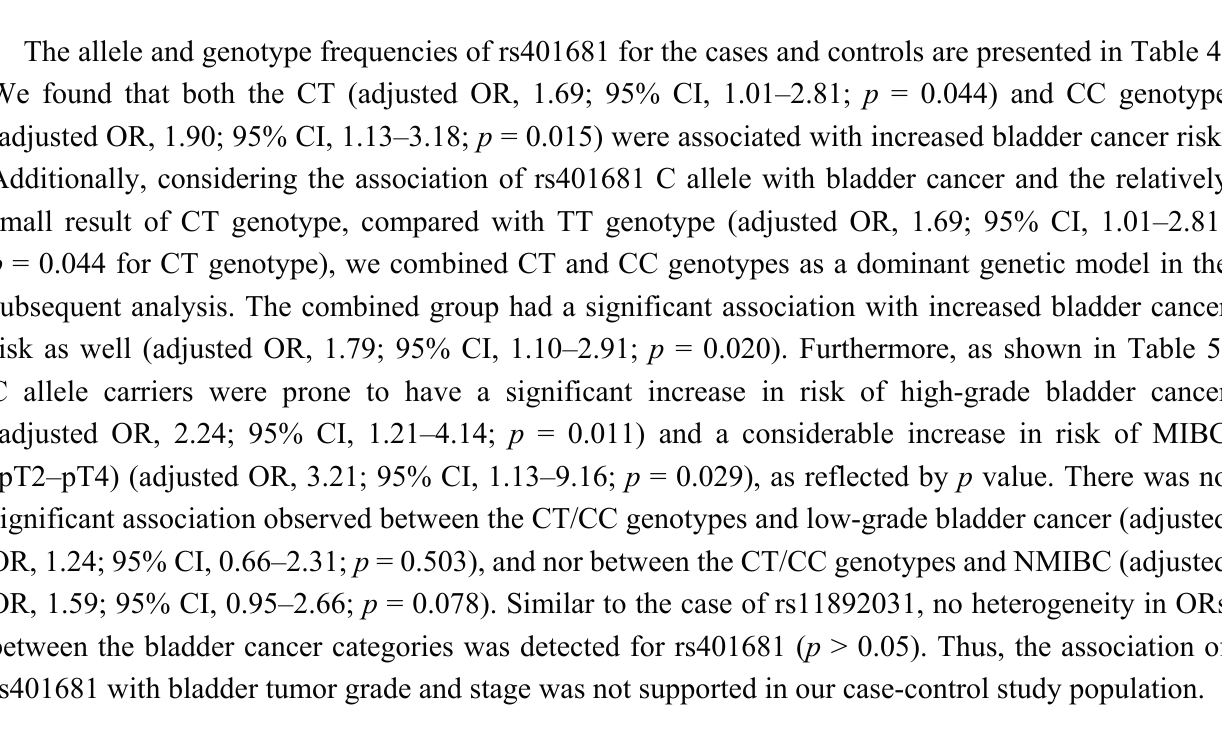
Table 4. Genotype and allele frequencies of the rs401681 polymorphism among cases and controls and their associations with risk of bladder cancer.